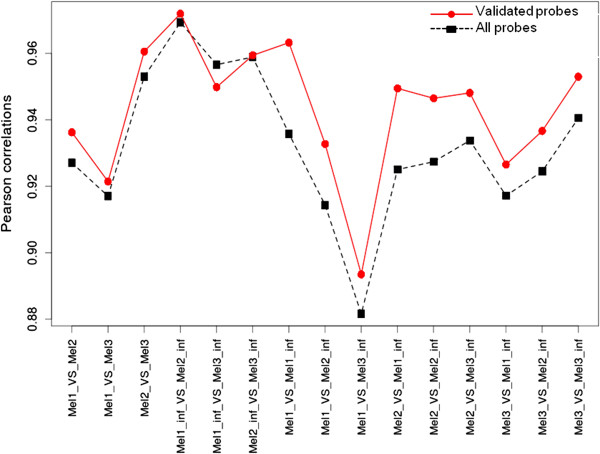
Pearson correlations among eggplant samples using total vs. validated probes. Pearson’s product moment correlation for eggplant samples were computed for the entire set of probes or the subset of eggplant validated set of probes. Correlations are shown for all pairs of sample combinations.